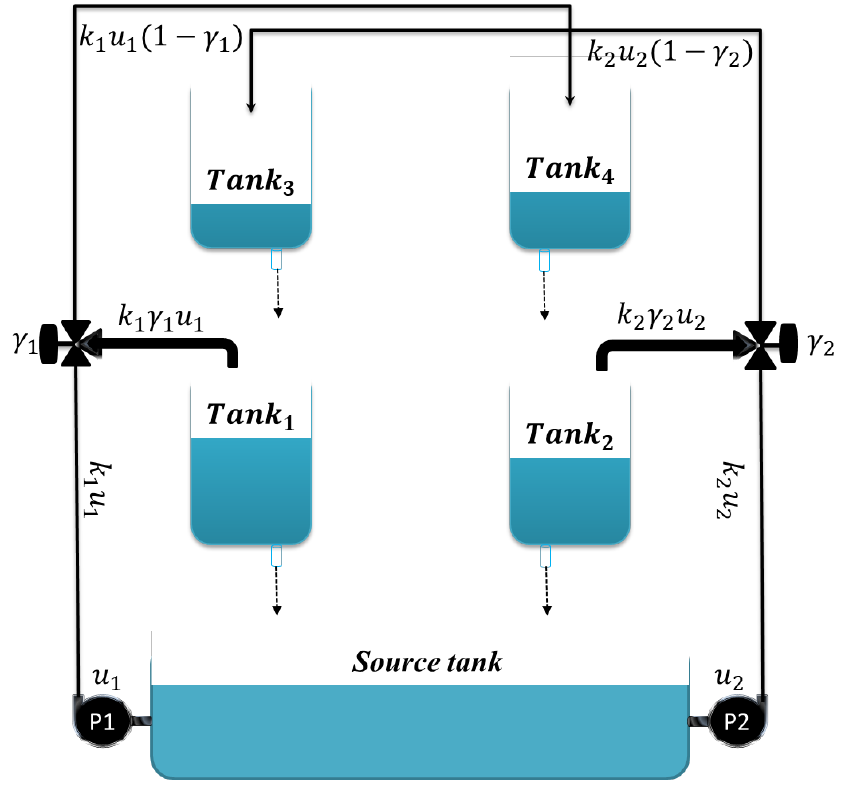
Figure 1. Four-tank system schematic diagram.